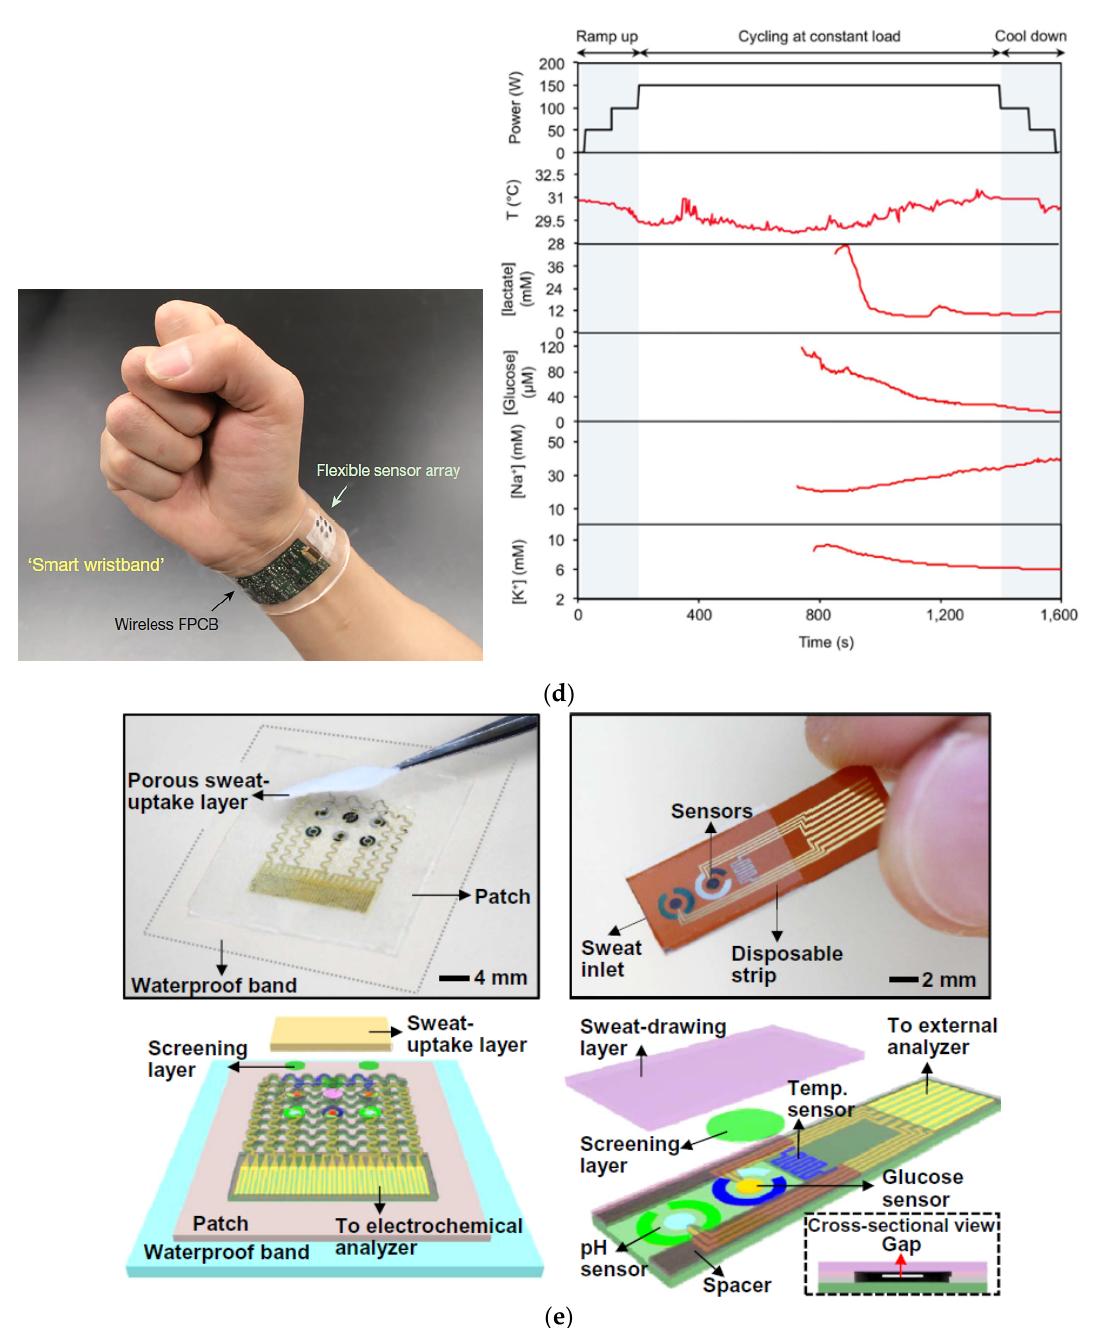
Figure 18. ( a ) Functional absorbent materials for sweat sampling in wearable sensors: An ion-selective sensor on a cellular substrate [49] (Reprinted with permission from ref. [49]. Copyright 2021 John Wiley and Sons); ( b ) wearable biosensors to detect glucose and alcohol on a hydrogel printed tattoo platform [50]; ( c ) wirelessly connected passive capacitive sensors for pH sensing [51] (Reprinted with permission from ref. [51]. Copyright 2021 John Wiley and Sons); ( d ) wearable sweat detection matrix multiplexed with an absorbent thin rayon pad placed between the skin and the sensor matrix for sampling [52] (Reprinted with permission from ref. [52]. Copyright 2021 Springer Nature); ( e ) wearable sweat monitoring patch (left) and disposable sweat monitoring strip (right) [53].